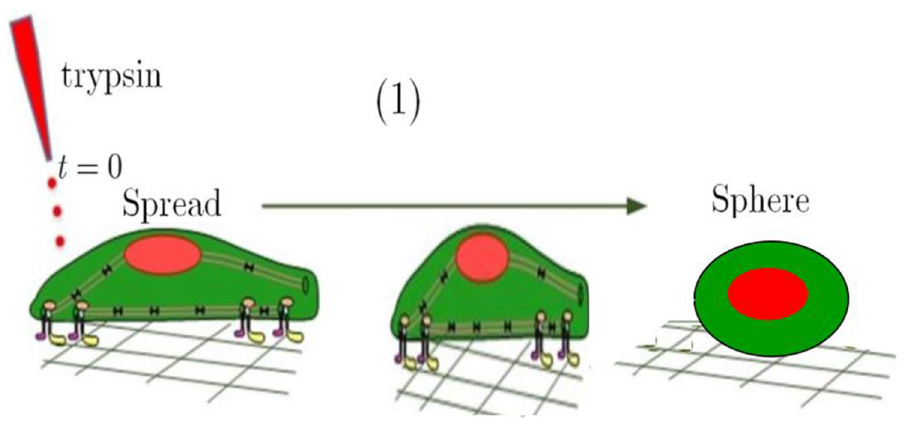
Figure 3. Schematic of de-adhesion